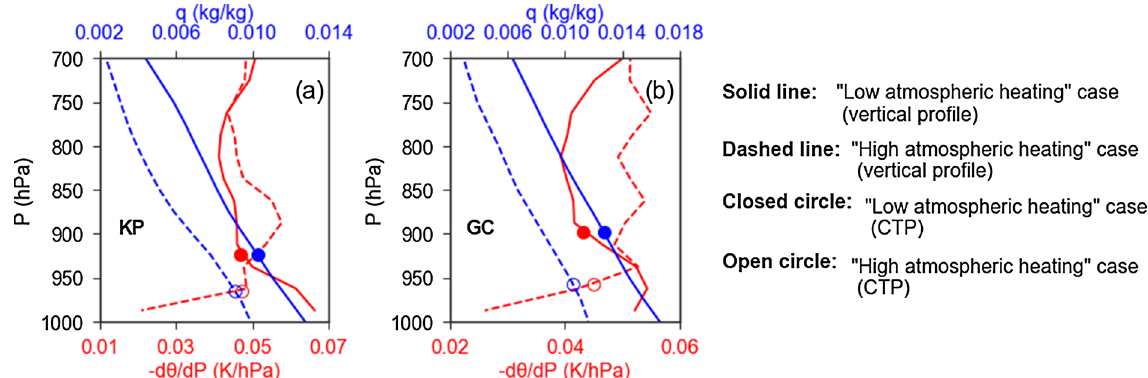
Figure 4. Vertical profiles of specific humidity (q) and potential temperature gradient (-dθ/dp) along with CTP for "low atmospheric heating" and "high atmospheric heating" cases for ( a ) Kanpur (KP) and ( b ) Gandhi College (GC)